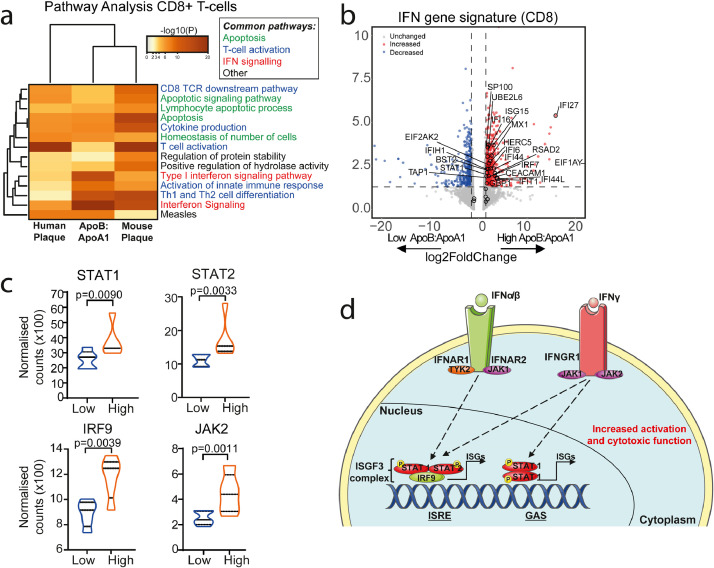
High ApoB:ApoA1 ratio patients have a CD8+ T-cell transcriptomic profile associated with atherosclerosis and interferon signalling.(a) Heatmap displaying -log10 p values of statistically significantly enriched genetic pathway ontology terms that overlap in CD8+ T-cell gene list analysis from human atherosclerotic plaques [43] (left), JSLE patients with high vs low ApoB:ApoA1 ratio (n=5/group) (middle), and mouse atherosclerotic plaques [44] (right). (b) Volcano plot (VolcaNoseR https://huygens.science.uva.nl/VolcaNoseR, date last accessed July 2020) showing genes associated with the Interferon (IFN) gene pathway ontology term identified in (a) in CD8+ T-cells from JSLE patients with high vs low ApoB:ApoA1 ratio (n=5/group). Genes overlapping with the SLE-associated IFN signature described in [45] are labelled. Log2 Fold change and p-value plotted, coloured points represent statistically significantly regulated genes. (c) Violin plots comparing normalised CD8+ T-cell gene counts from JSLE patients with high vs low ApoB:ApoA1 (n=5/group) in the IFN-stimulated gene factor 3 transcription complex (ISGF3) complex IFN signaling pathway. Unpaired t test. (d) Summary diagram of ISGF3 signaling. Abbreviations: Interferon-α/β/γ (IFNα/β/γ), interferon regulatory factor 9 (IRF9), interferon stimulated genes (ISGs). Janus kinase 2 (JAK2), signal transducer and activator of transcription 1/2 (STAT1/2), tyrosine kinase 2 (TYK2), interferon alpha and beta receptor subunit 1/2 (IFNAR1/2), interferon gamma receptor 1 (IFNGR1), interferon sensitive response element (ISRE), gamma-activated sequence (GAS), phosphate group (P) (also see Supplementary Fig. 9).